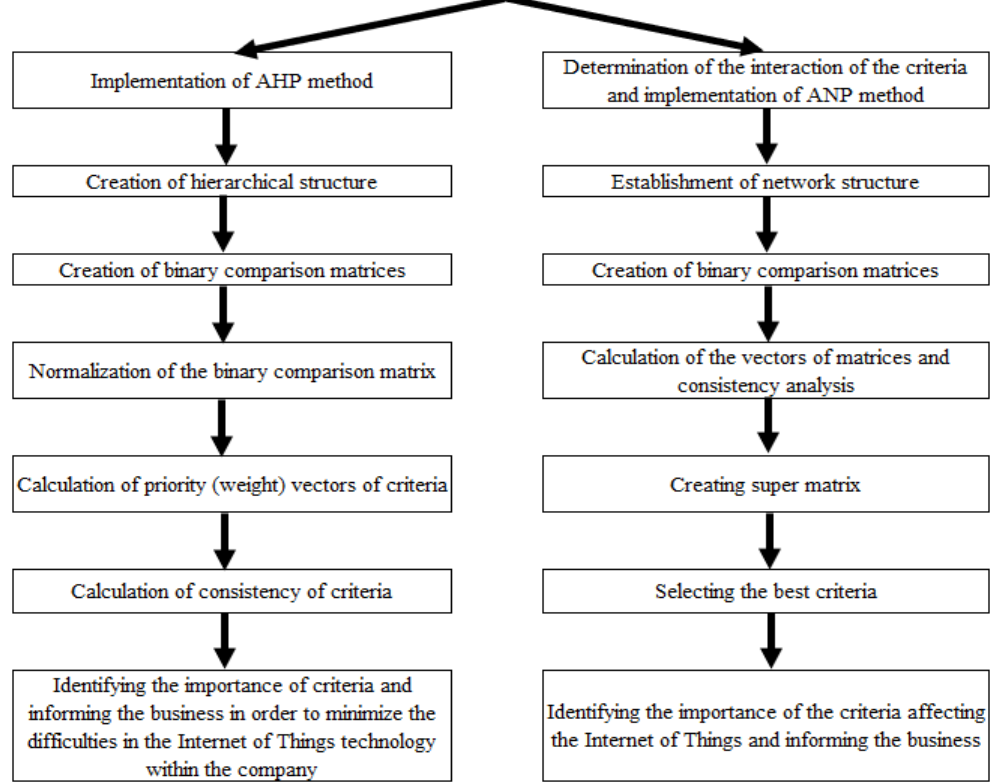
Figure 1. Flowchart of the problem .